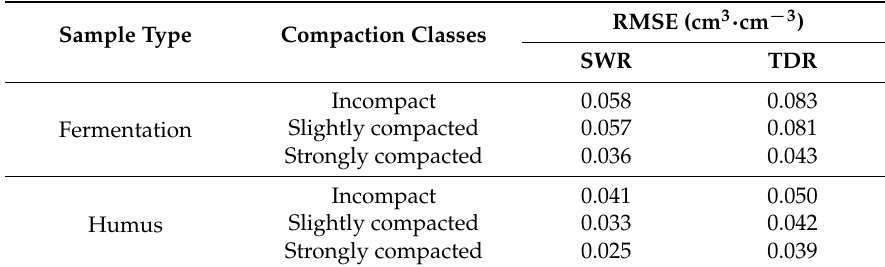
Table 2. Root mean square error (RMSE) of volumetric water content measurements using SWR and TDR in fermentation and humus with three different compaction classes.